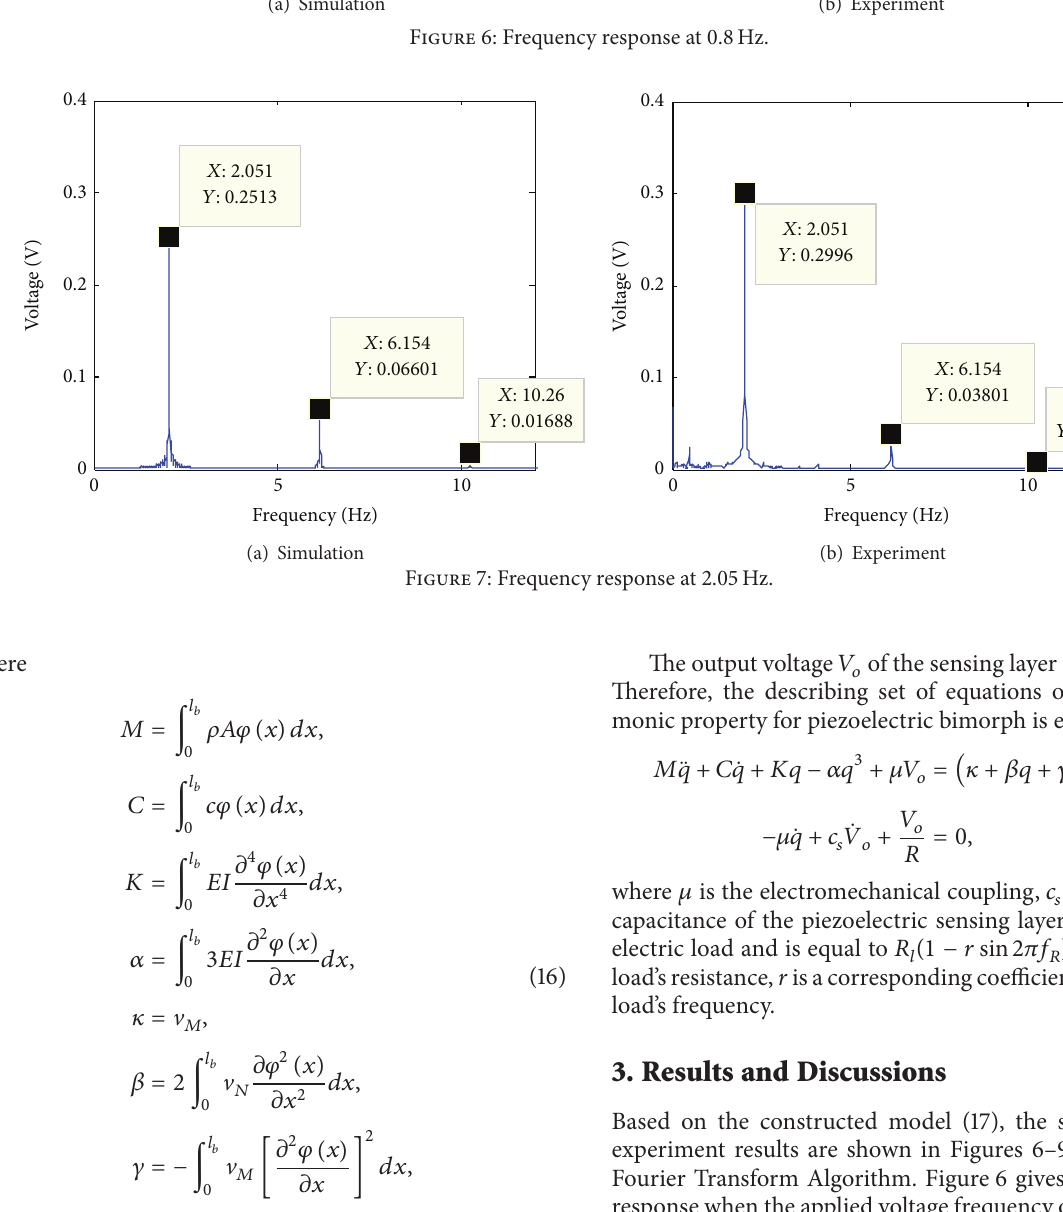
Figure 6: Frequency response at 0.8 Hz.